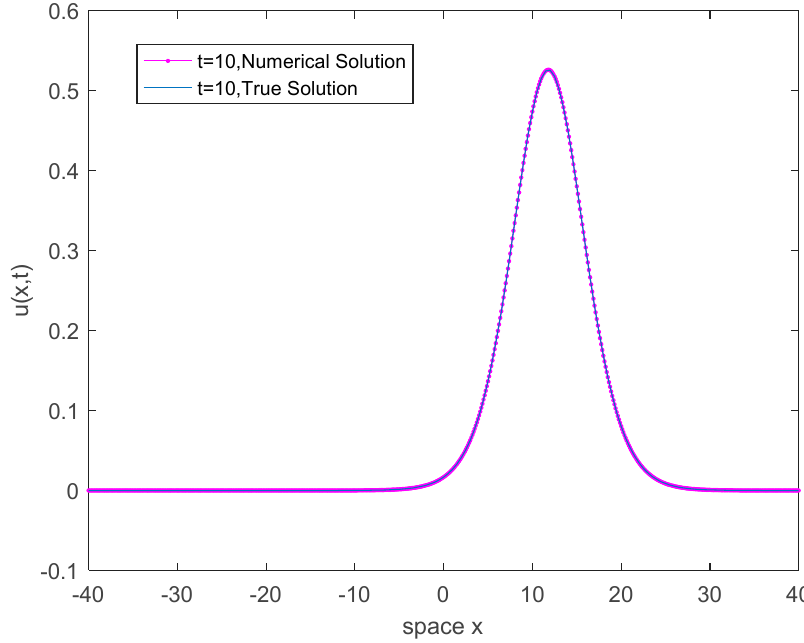
Figure 6. Numerical solution and exact solution with h = τ = 1/8 , t = 10.